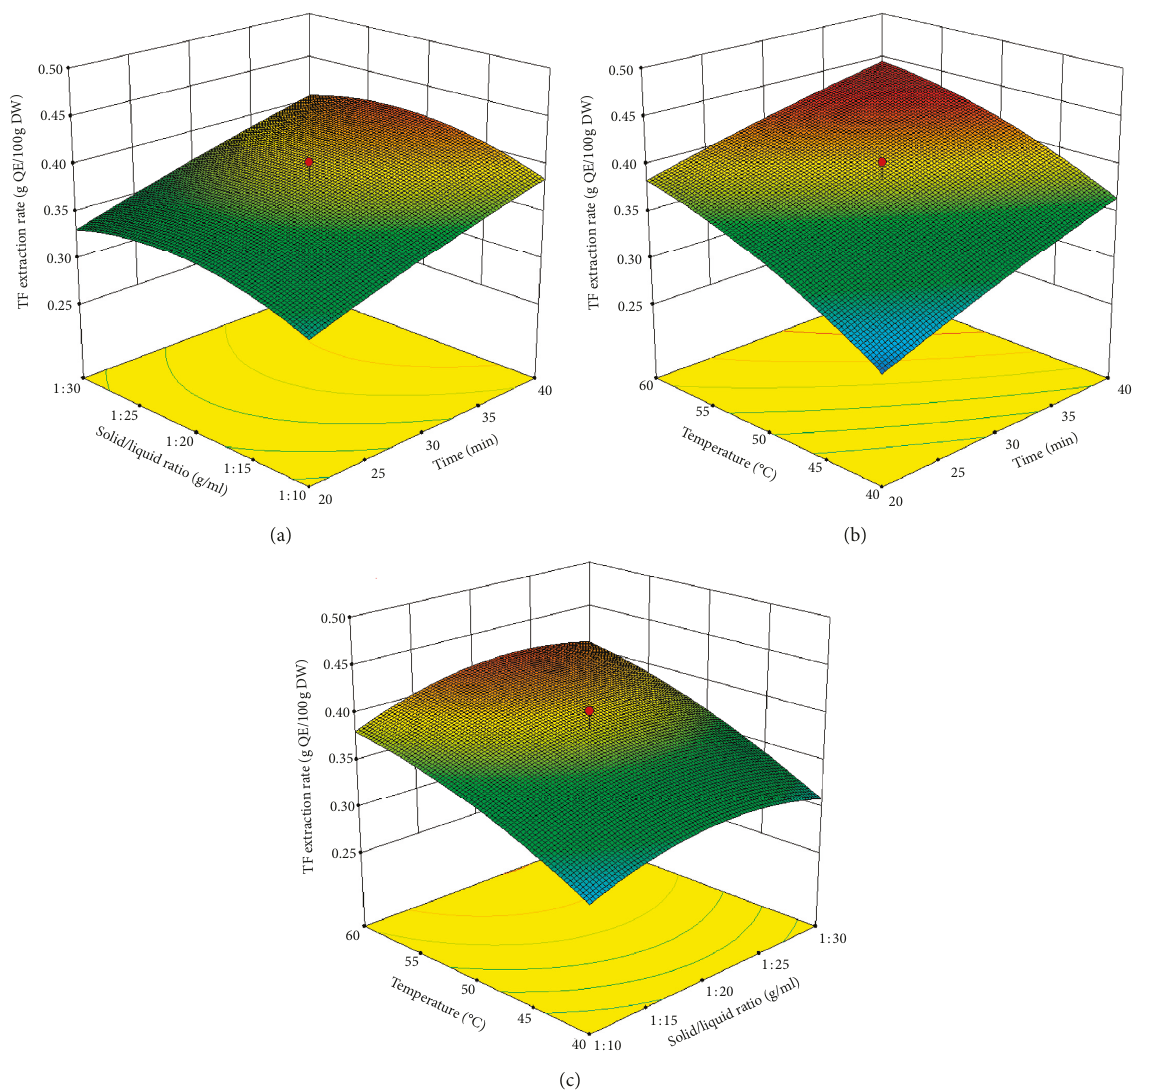
Figure 4: Response surface plots for TF extraction rate affected by (a) solid/liquid ratio and extraction time (extraction temperature was set at 50 ° C), (b) extraction temperature and time (solid/liquid ratio was set at 1:20), and (c) extraction temperature and solid/liquid ratio (extraction time was set at 20 min). Table 6: Predicted and experimental values of total flavonoids (TF) extraction rate under optimum conditions. Optimum conditions